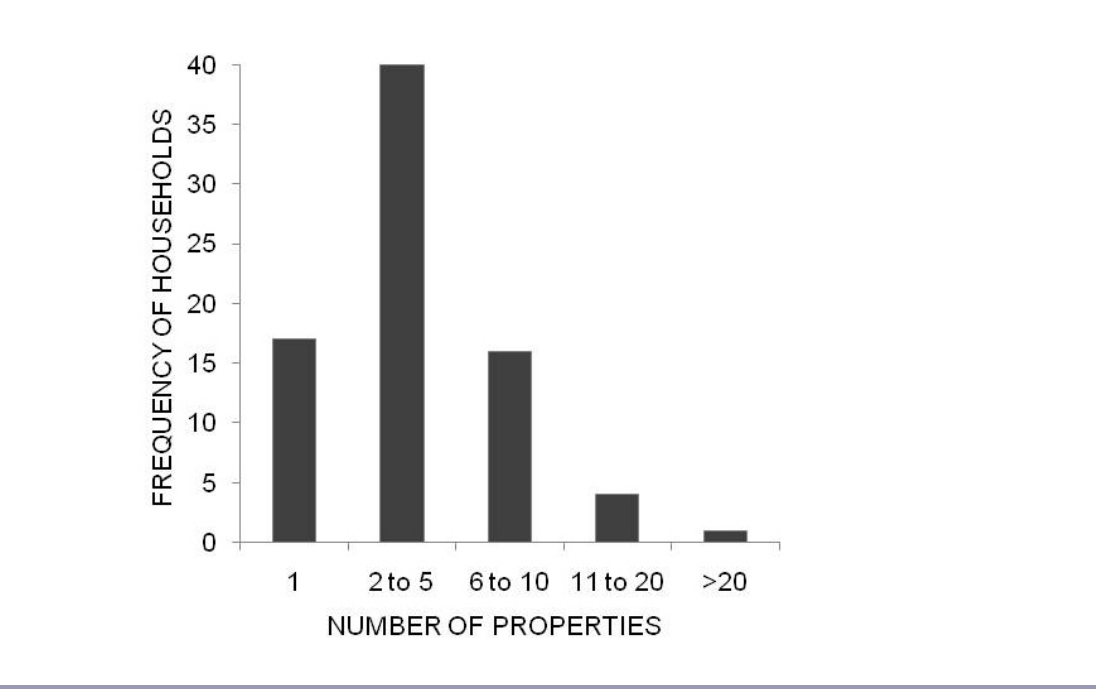
Fig. 3 . Number of properties accumulated per